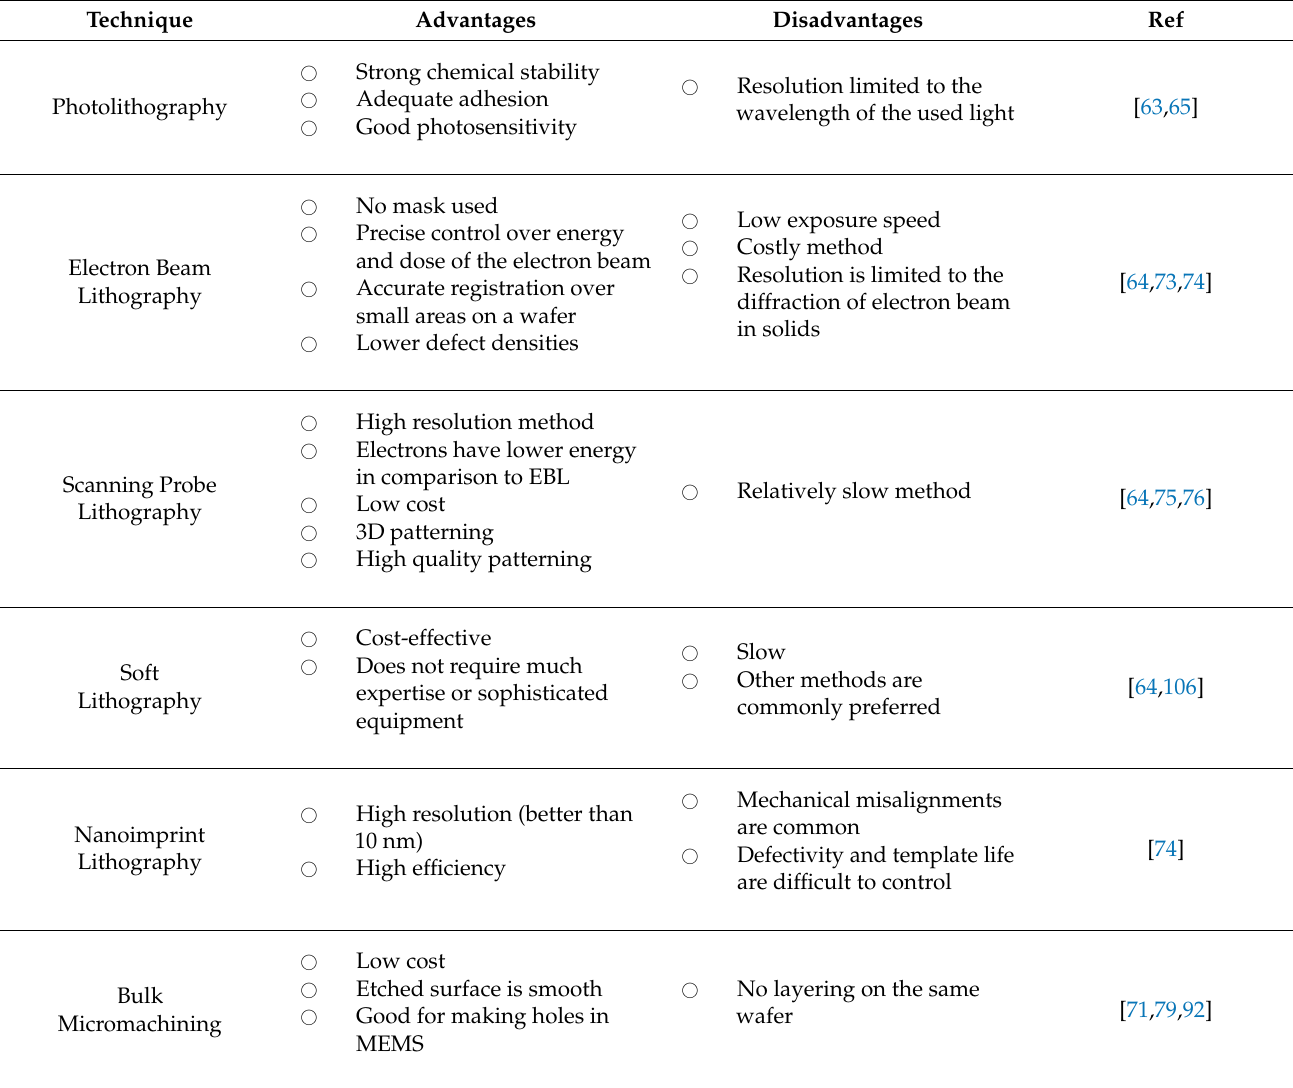
Table 1. Advantages and disadvantages of bioNEMS/MEMS fabrication